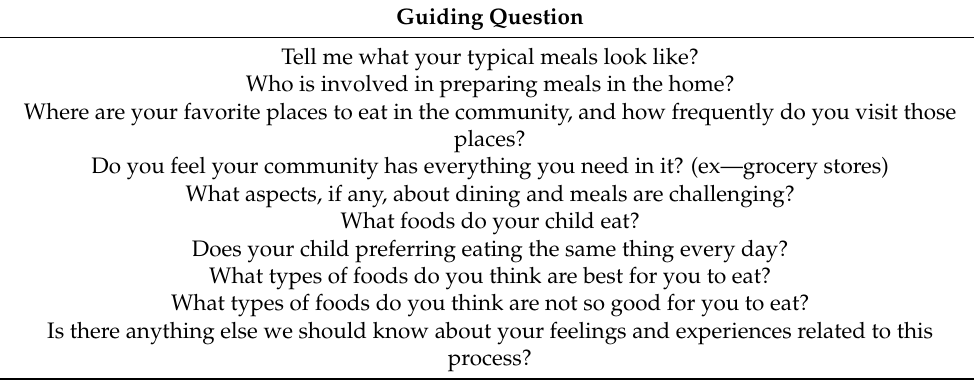
Table 1. Sample Interview